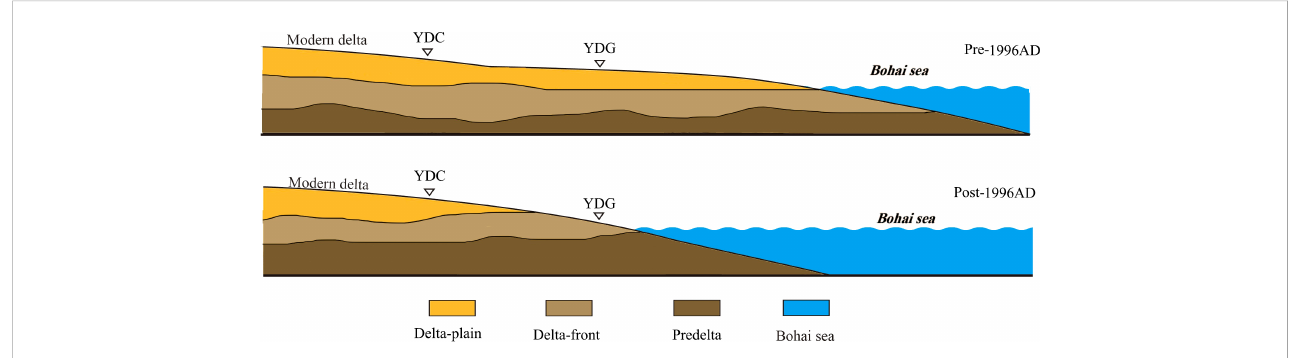
FIGURE 7 Sedimentary facies variation in the Yellow River Delta around 1996 (Zeng et al., 2022).